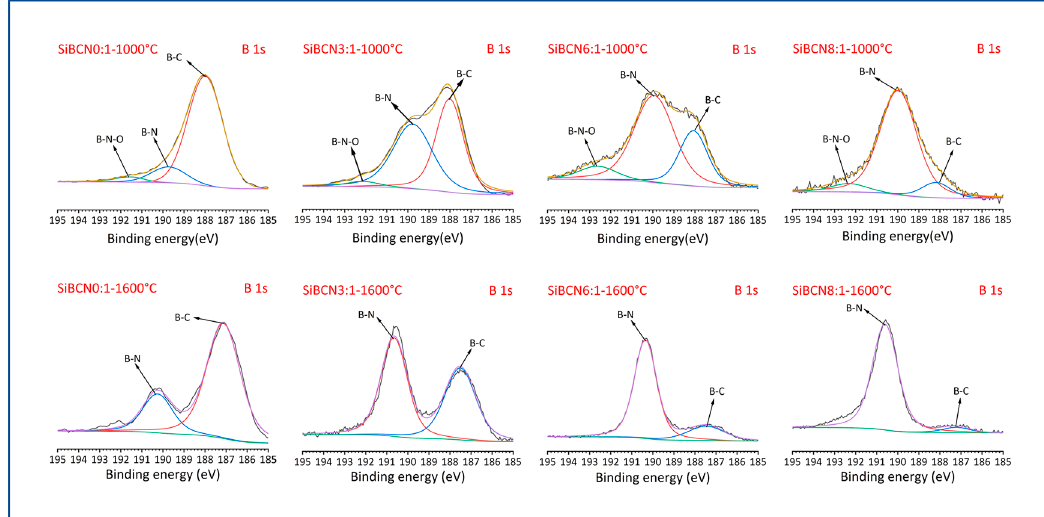
Figure 3. XPS spectra of B 1s of SiBCN x:y at 1000 °C and 1600 °C.